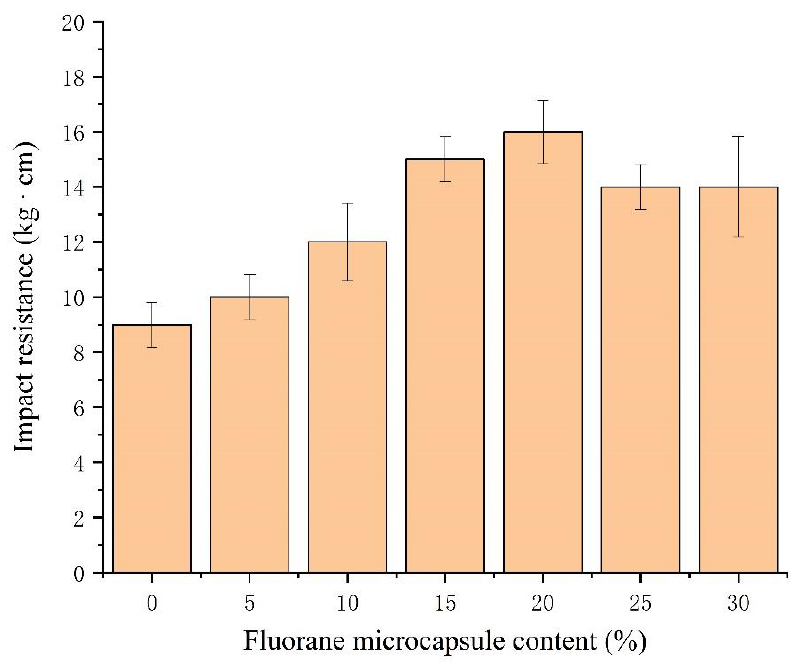
Figure 10. The fluorane microcapsule content on film impact resistance.